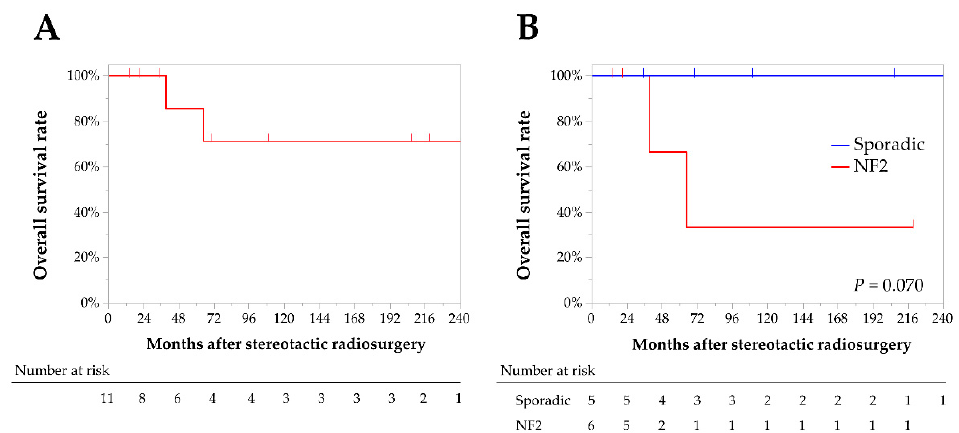
Figure 3. Kaplan–Meier curves for the overall survival rates in all patients ( A ), and a comparison between sporadic and neurofibromatosis-type-2-related intraventricular meningiomas ( B ).